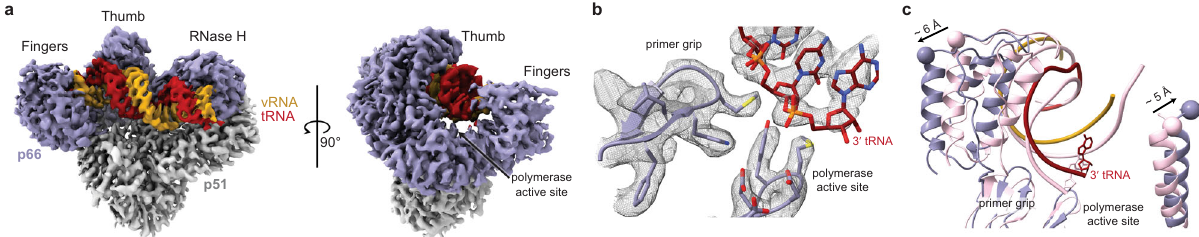
Fig. 2 Improved resolution of the HIV-1 RTIC structure. a In all, 2.8-Å map of the miniRTIC colored by chain (p66 = purple, p51 = gray, vRNA template = gold, and tRNA primer = red). Map rotated by 90° (right) to display end-on view of polymerase-active site. b 3 ′ tRNA Lys 3 terminus (red) is not engaged with the polymerase-active site (see c for comparison to a structure with the primer terminus engaged). The polymerase-active site, primer grip, and 3 ′ tRNA Lys 3 are displayed within their corresponding EM density. The β -OG molecule is hidden for clarity (Supplementary Fig. 4a). c The miniRTIC (purple/ gold/red) is captured in an inactive polymerase conformation. The miniRTIC 3 ′ tRNA terminus is displaced away from the active site and the fi nger and thumb subdomains are hyperextended (~6 and ~5 Å, respectively) compared to an active polymerase RT – dsDNA complex (1RTD [https://doi.org/ 10.2210/pdb1rtd/pdb], pink). Models are aligned on palm domain backbone residues ( “ Methods ” ).